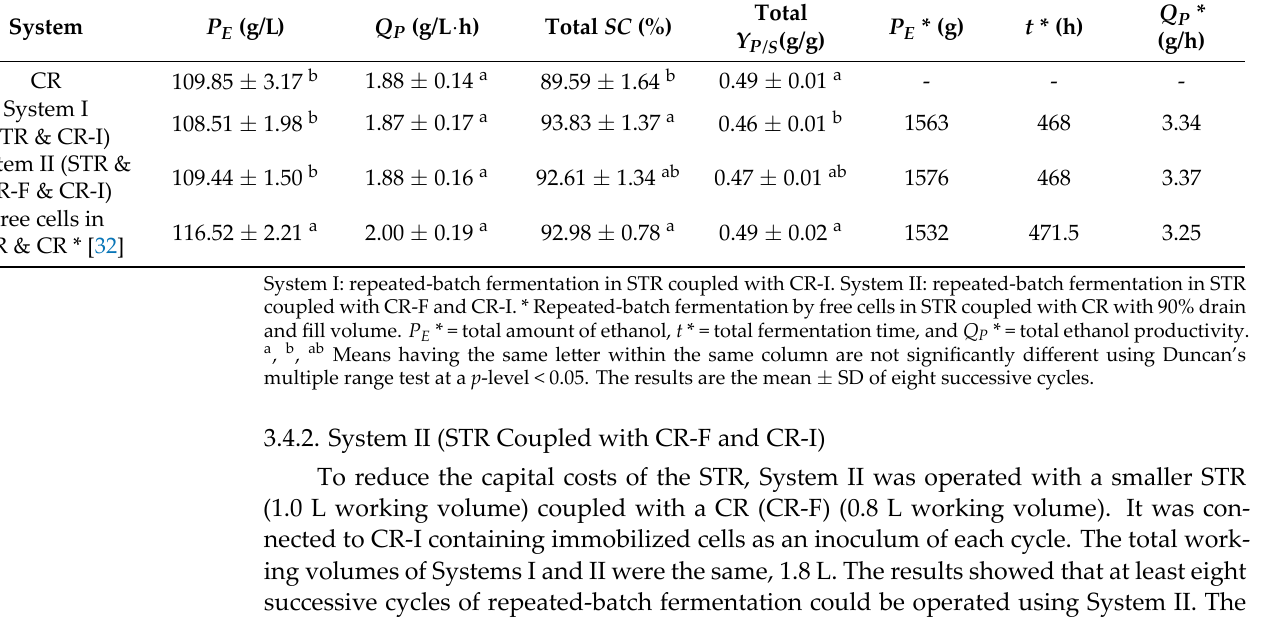
yield (g/g), and t = fermentation time (h). a , b , c , ab Means having the same letter within the same column are not significantly different when using Duncan’s multiple range test at a p -level < 0.05. The results are expressed as the mean ± SD of triplicate experiments.